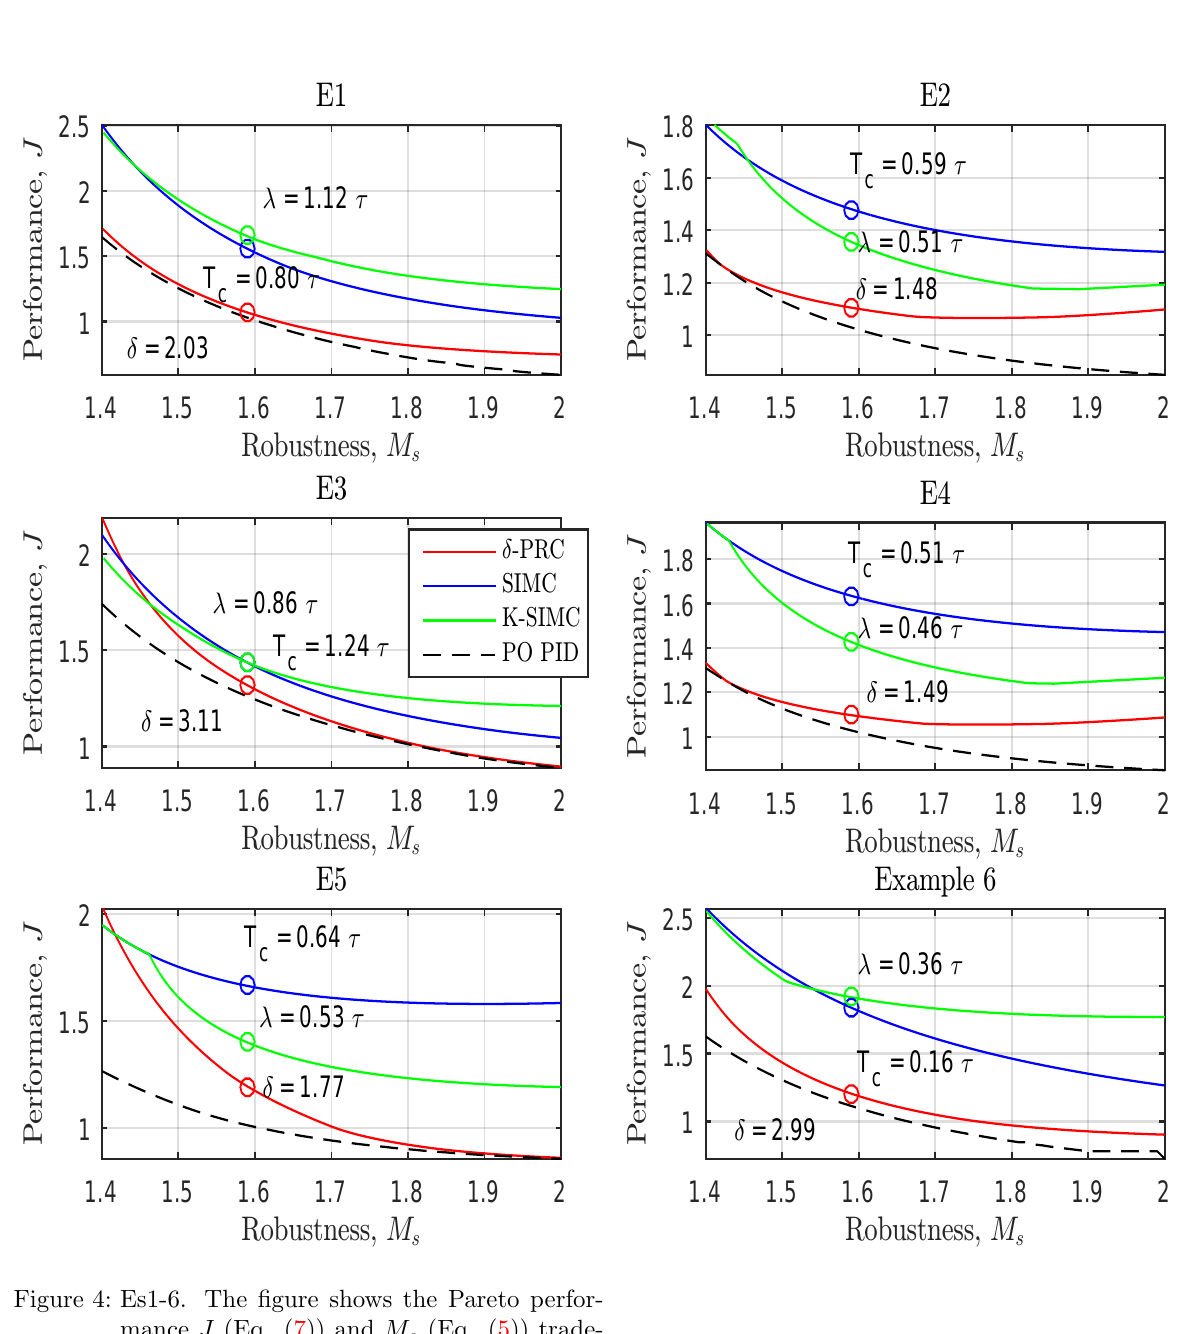
Figure 4: Es1-6. The figure shows the Pareto perfor- mance J (Eq. (7)) and M s (Eq. (5)) trade- off curves for the methods δ -PRC ( δ ), SIMC ( T c ), K-SIMC ( λ ) and PO PID ( M s ), where δ is the prescribed relative time delay er- ror, T c and λ are the prescribed set point response time constants. The circles illus- trates controllers with prescribed robustness M s = 1 .